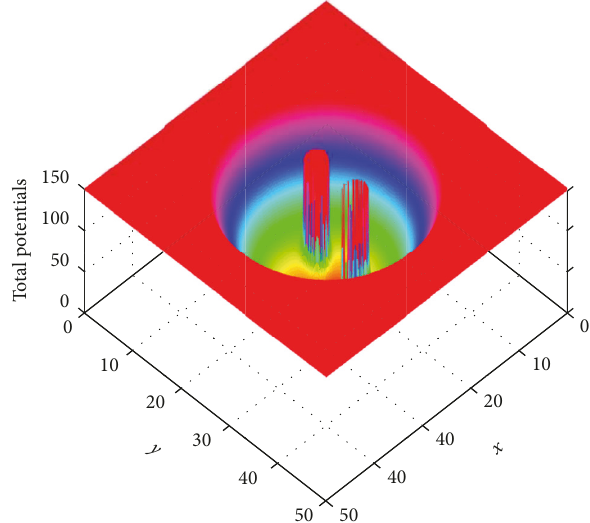
Figure 4: Total potentials, with (𝑝 1 ,𝑝 2 ) = (25,12.5) , 𝑟 0 = 1.25 , while 𝛼 12 = 0.01 , 𝛾 12 = 0.01 , 𝑀 12 = 5.0 , and 𝑁 12 = 3.0